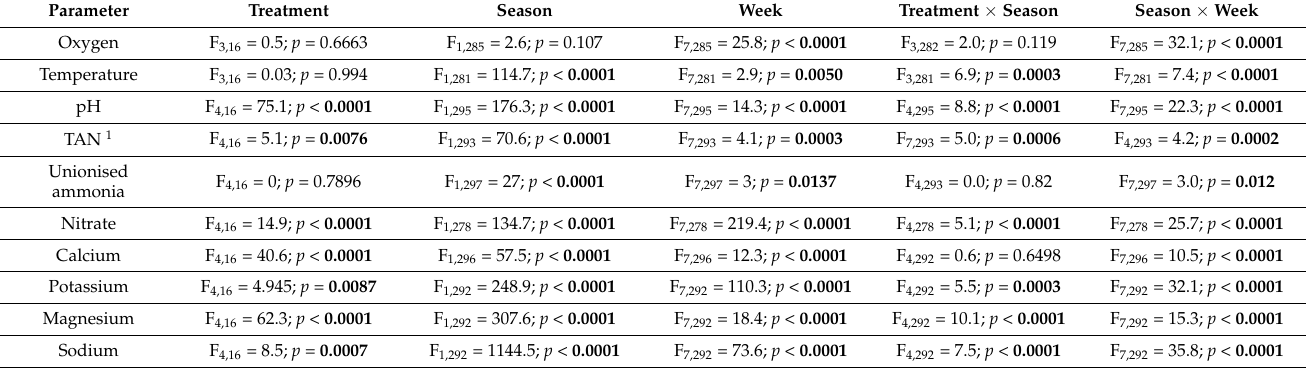
Table 1. Full statistical results for water quality. ANOVA results showing F values, degrees of freedom and p values for all water parameters tested as a function of enrichment treatment, season and week with interactions between factors. Significant p values are indicated in